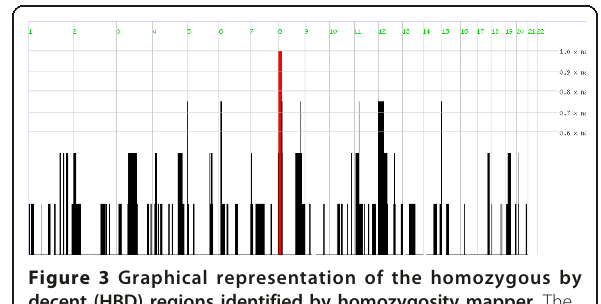
Figure 3 Graphical representation of the homozygous by decent (HBD) regions identified by homozygosity mapper . The red bar indicates the HBD identified on chromosome 8.